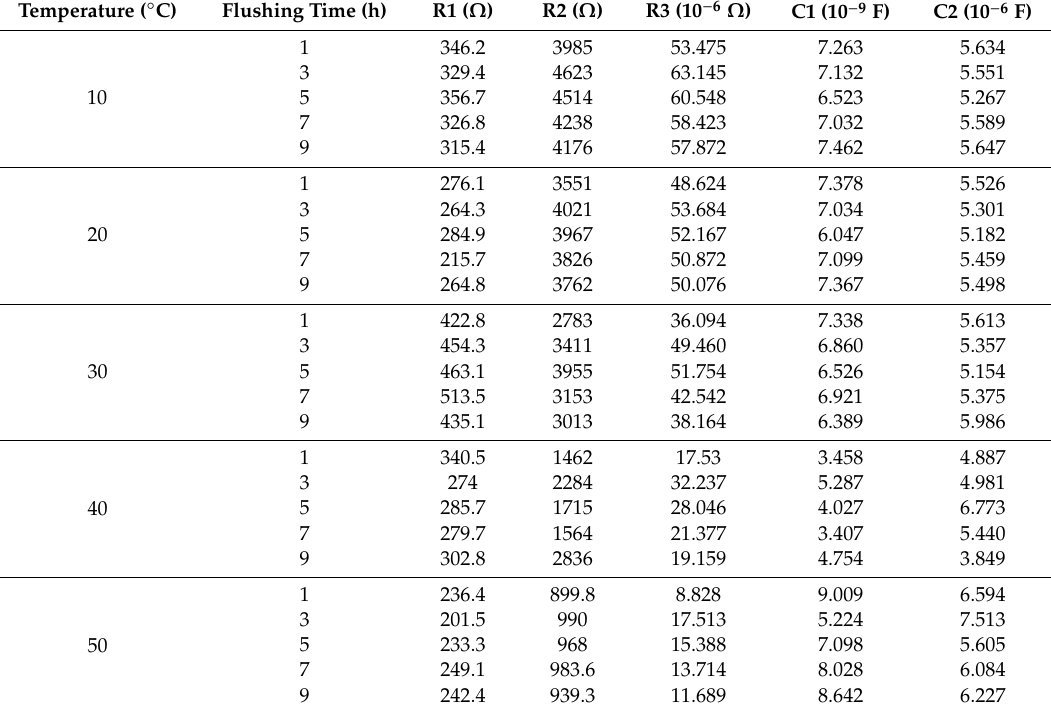
Table 2. EIS parameters of aluminum electrodes obtained by fitting the data to the equivalent circuit